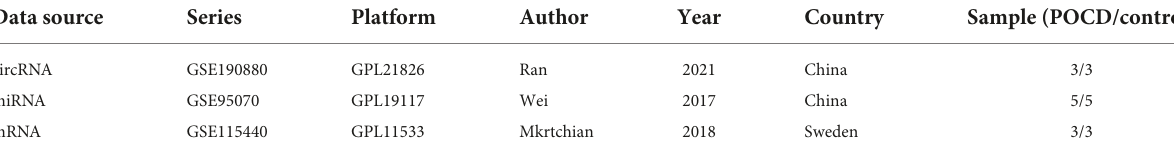
TABLE 1 The profiles of three microarray datasets from the GEO database. Data source Series